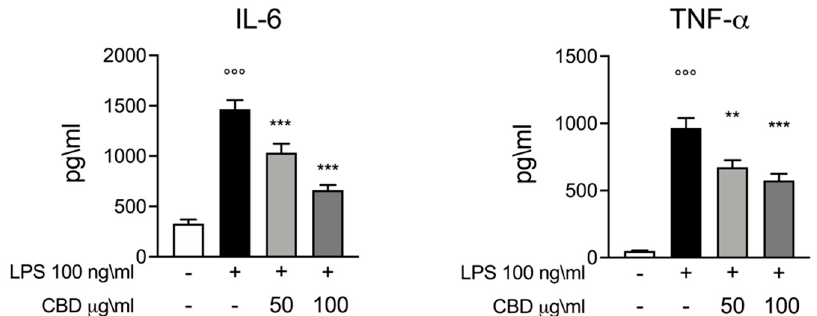
Figure 1. ELISA assay for IL-6 and TNF- α whole blood culture supernatant 24 h after LPS 100 ng/mL stimulation. Data are presented as means ± SEM for each group. ◦◦◦ p < 0.01 vs. control; ** p < 0.01 vs. LPS; *** p < 0.001 vs. LPS.